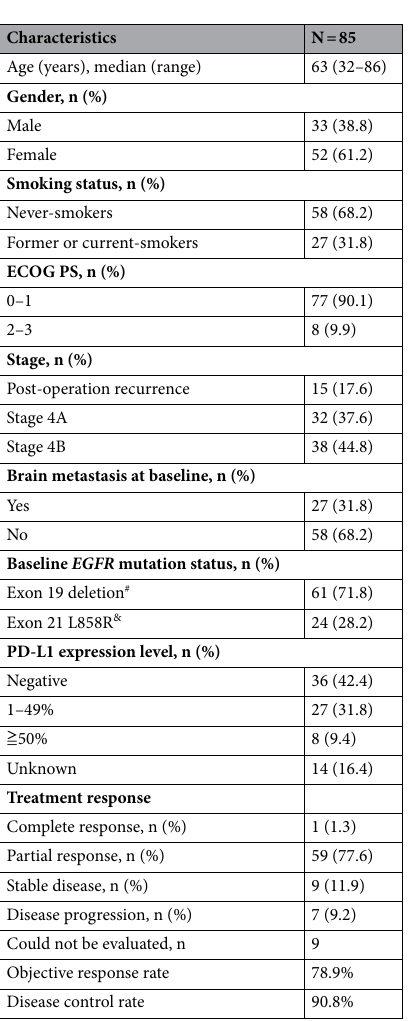
Table 1. Patients’ characteristics and demographic data. ECOG PS, Eastern Cooperative Oncology Group performance status; EGFR, epidermal growth factor receptor; PD-L1, Programmed death-ligand 1. # 1 Exon